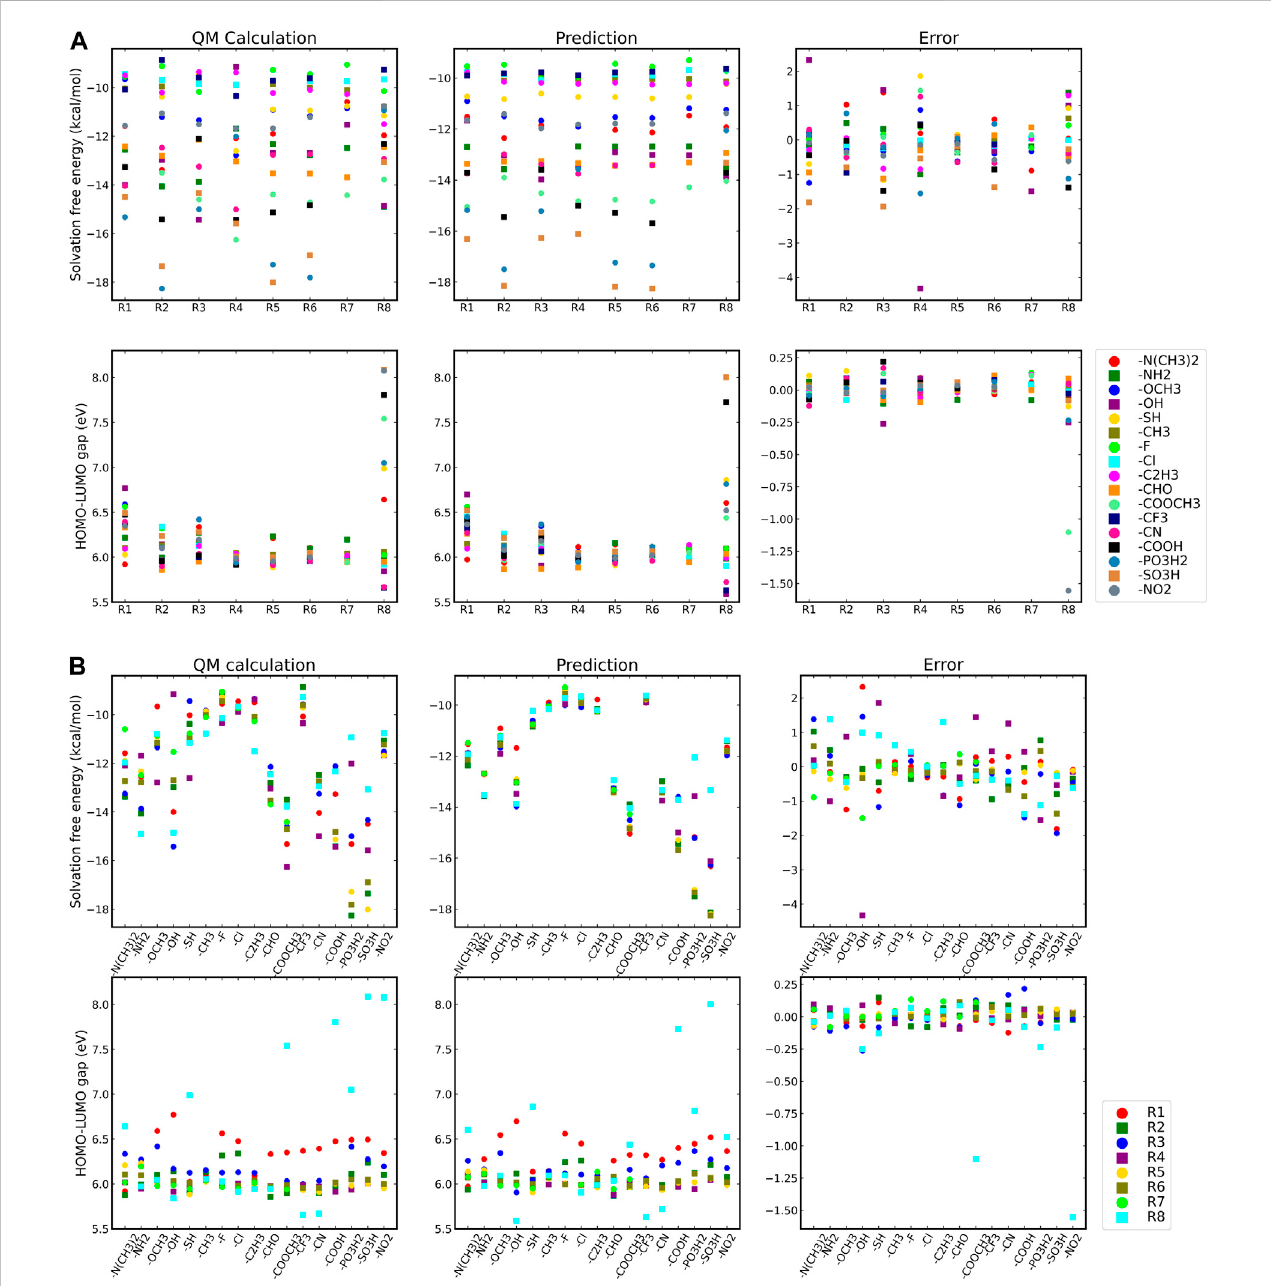
FIGURE 3 Solvation-freeenergiesand HOMO-LUMO gaps of different quinones. (A) Effect of different substituenttypes on target properties. (B) Effect ofdifferent substituent positions on target